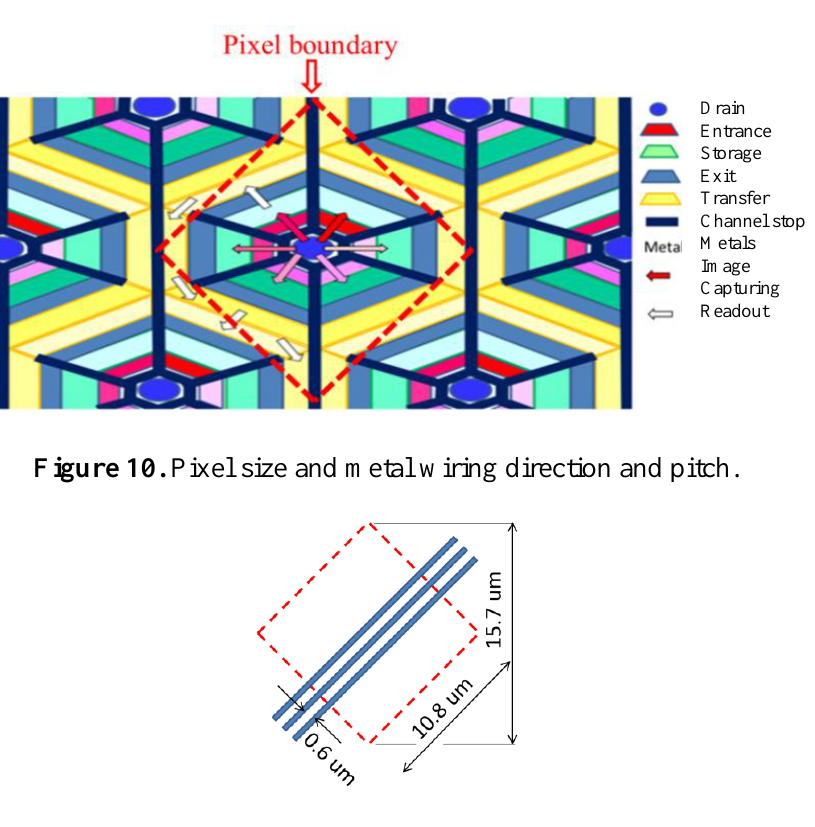
Figure 11. Masks for the p-well creating an electronic microlens